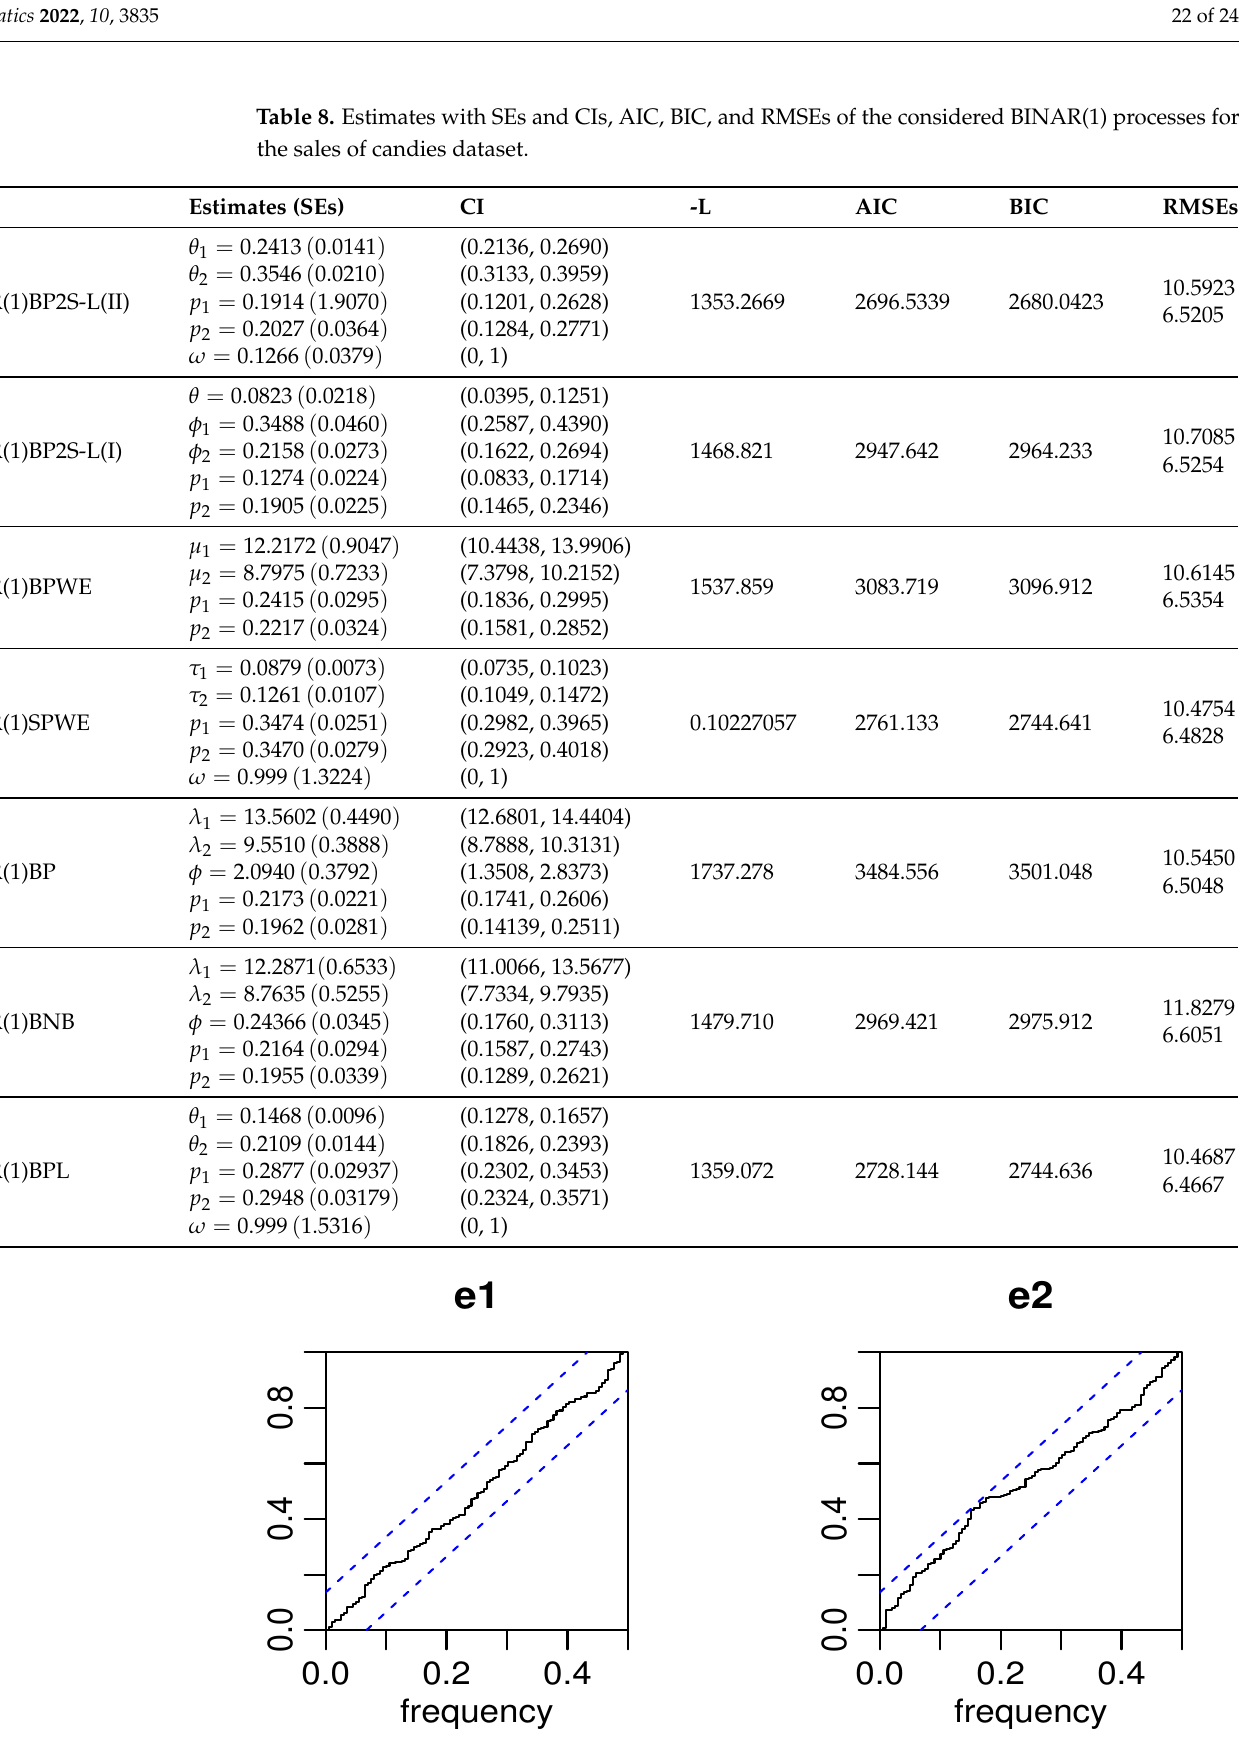
Figure 12. Cpgrams of standardized residuals of Candies1 and Candies2 data for the